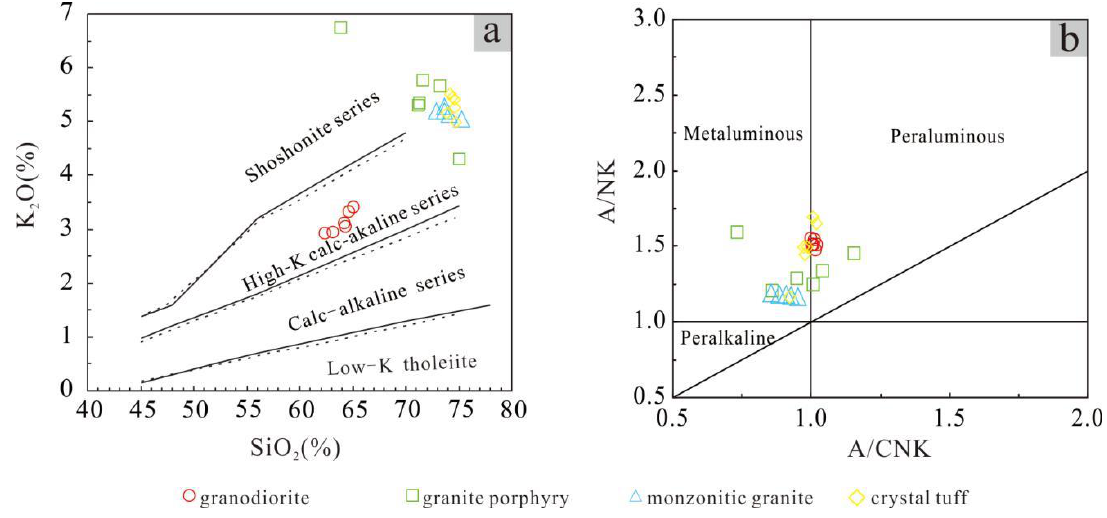
Figure 5. Discrimination diagrams for granitic rocks and crystal tuff of the Hutouya deposit: ( a ) K 2 O– SiO 2 [51]; ( b ) A/NK–A/CNK [52].